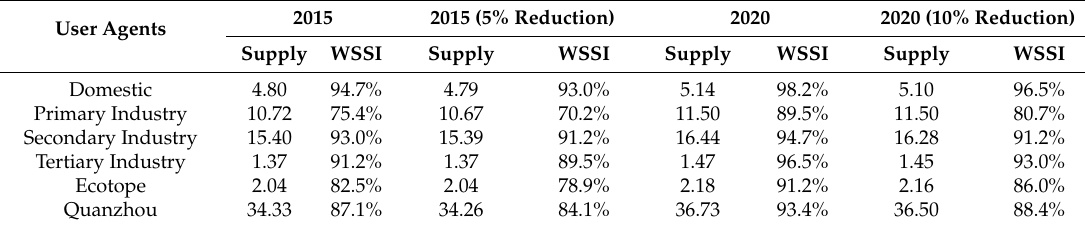
Table 2. Average water supply and WSSI of User Agents after the long-series optimal